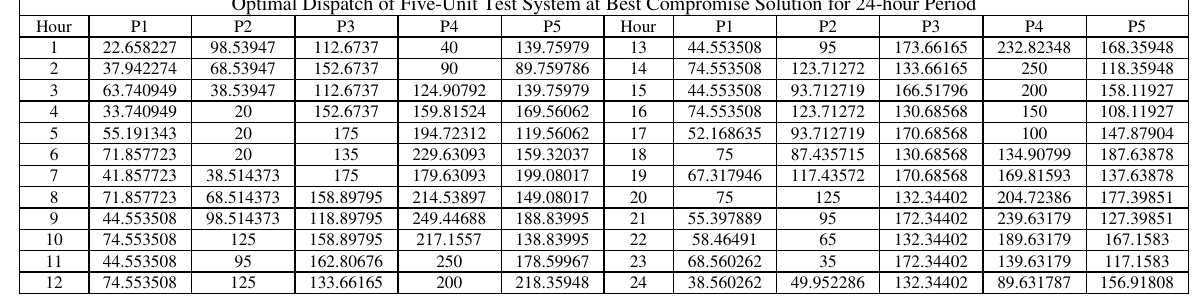
Table 1: Optimal Dispatch of five-Unit Test System at Best Compromise Solution for 24-Hour Period